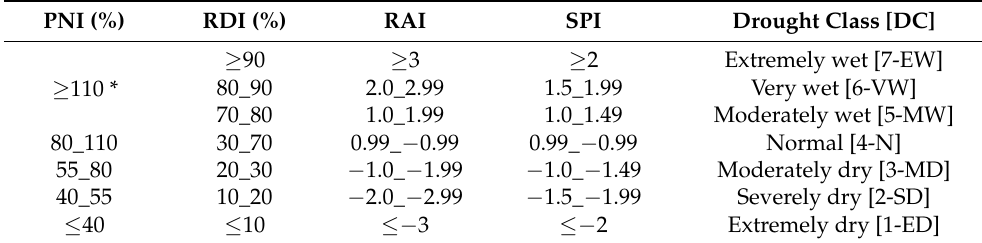
Table 1. DC and drought indices limit values for SPI, RAI, RDI, and PNI.